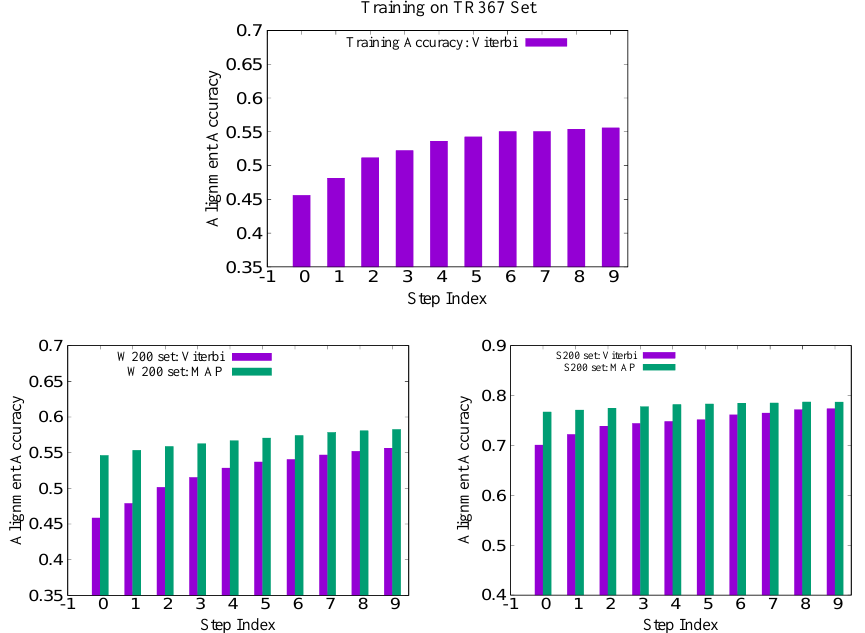
Figure 10. ( Top ) Training alignment accuracy on TR367 set with the five-state model training. ( Bottom left ) Test alignment accuracies on W200 set with the same five-state model; both Viterbi alignment and MAP alignment accuracies are shown. ( Bottom right ) Test alignment accuracies on S200 set with the same five-state model (below). Table 2. Alignment accuracies in the test sets W200 and S200 based on training with TR367.